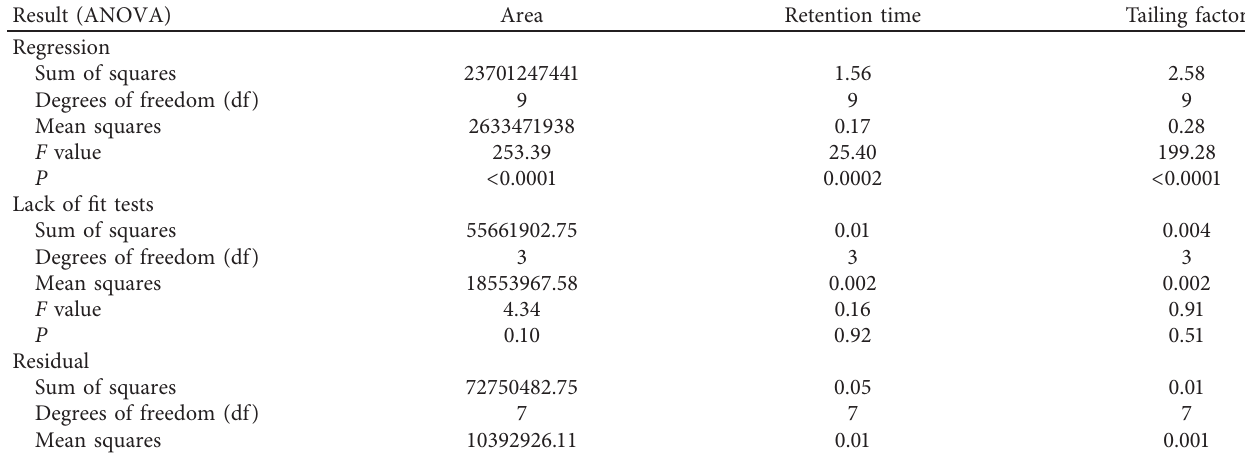
� area; Y � retention time; Y � tailing factor). 1 2 3